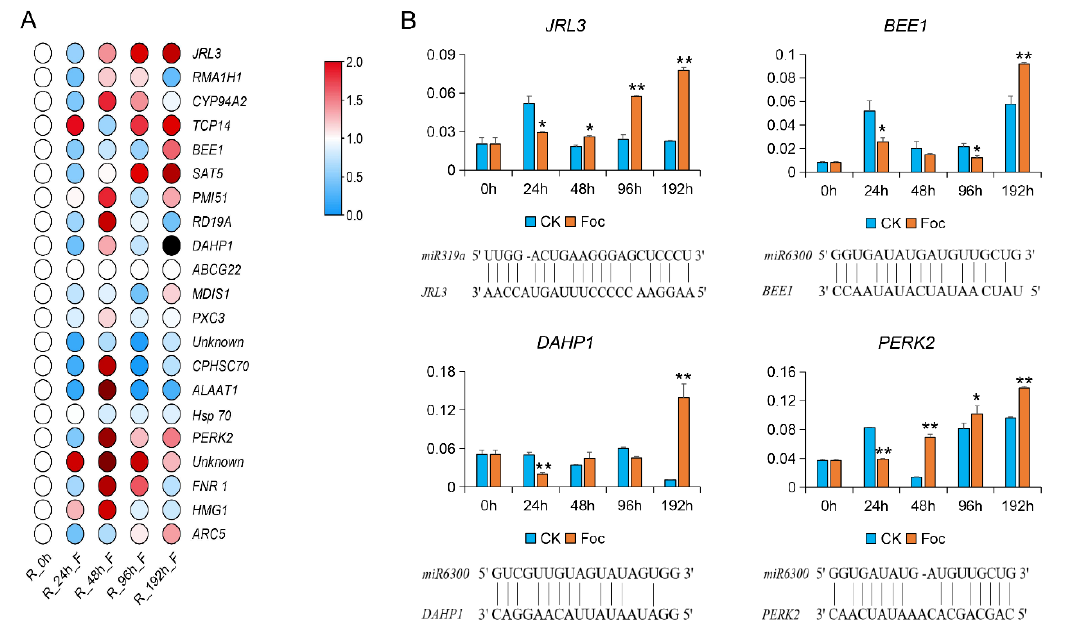
Figure 5. Validation of the target genes in cucumber inoculated with Foc. ( A ) Target gene expression levels in the Foc- inoculated cucumber roots and the mock-inoculated control roots were calculated according to the 2 −ΔΔCt method. Genes more highly or more weakly expressed in the roots were colored red and blue, respectively; ( B ) Expression patterns of four candidate target genes as well as the matches between miR6300 and miR319a and selected target genes. Data are presented as the mean ± standard error of three biological replicates. *: significantly different at p < 0.05; **: significantly different at p < 0.01.